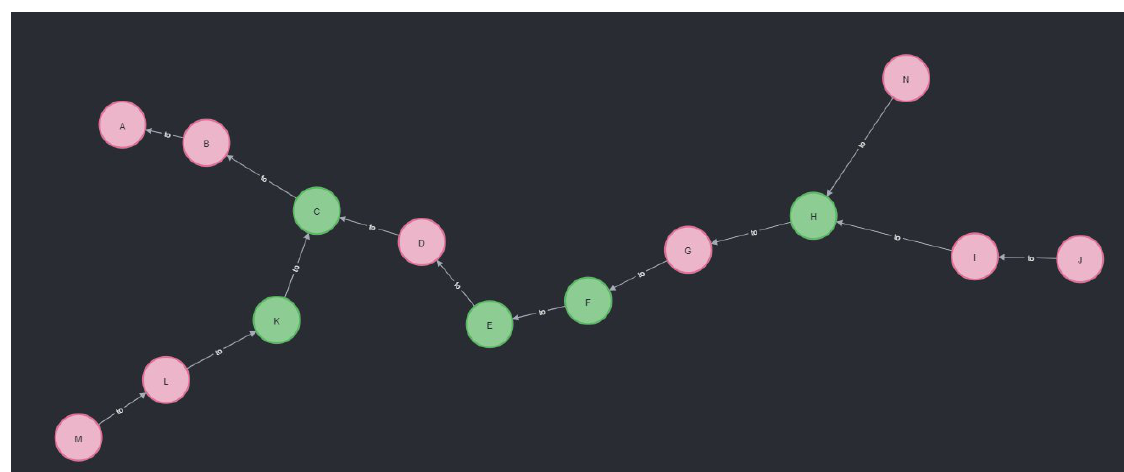
Figure 4. The transportation network version of the river system of Figure 3. All nodes correspond to river segments and the segments equipped with a sensor are indicated in pink. All segments have an ID which is a letter. For each segment with a sensor this ID coincides with the IDs used to denote the sensor in Figure